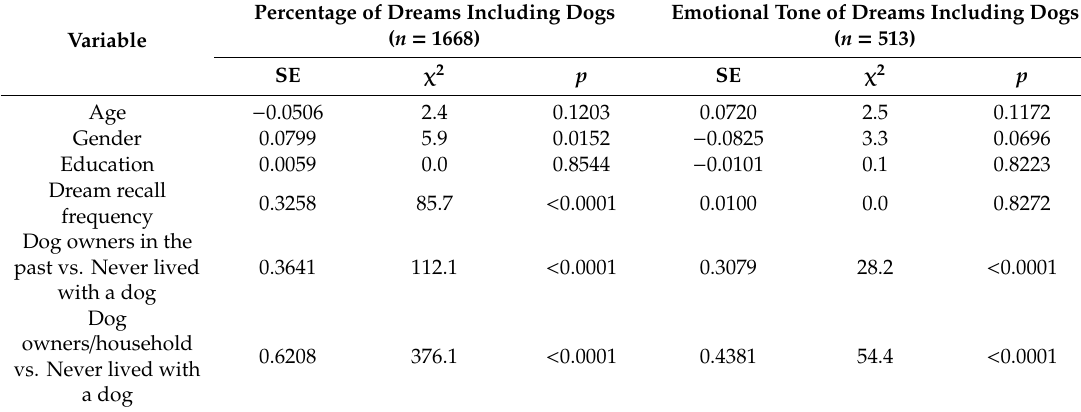
Table 4. Ordinal regression analysis for the categorized (ordinal) percentage of dreams that include dogs and emotional tone of dreams that include dogs.